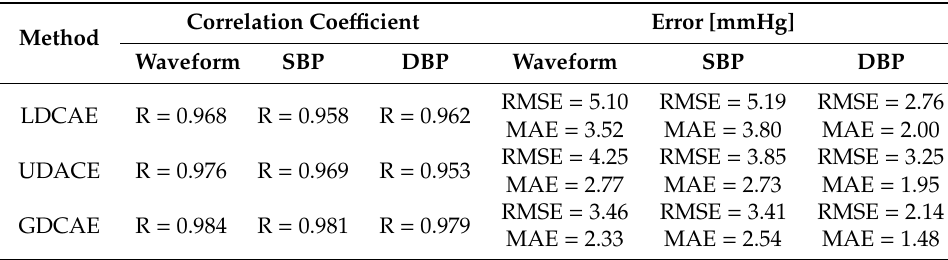
Table 3. Comparison between the LDCAE, UDCAE and GDCAE